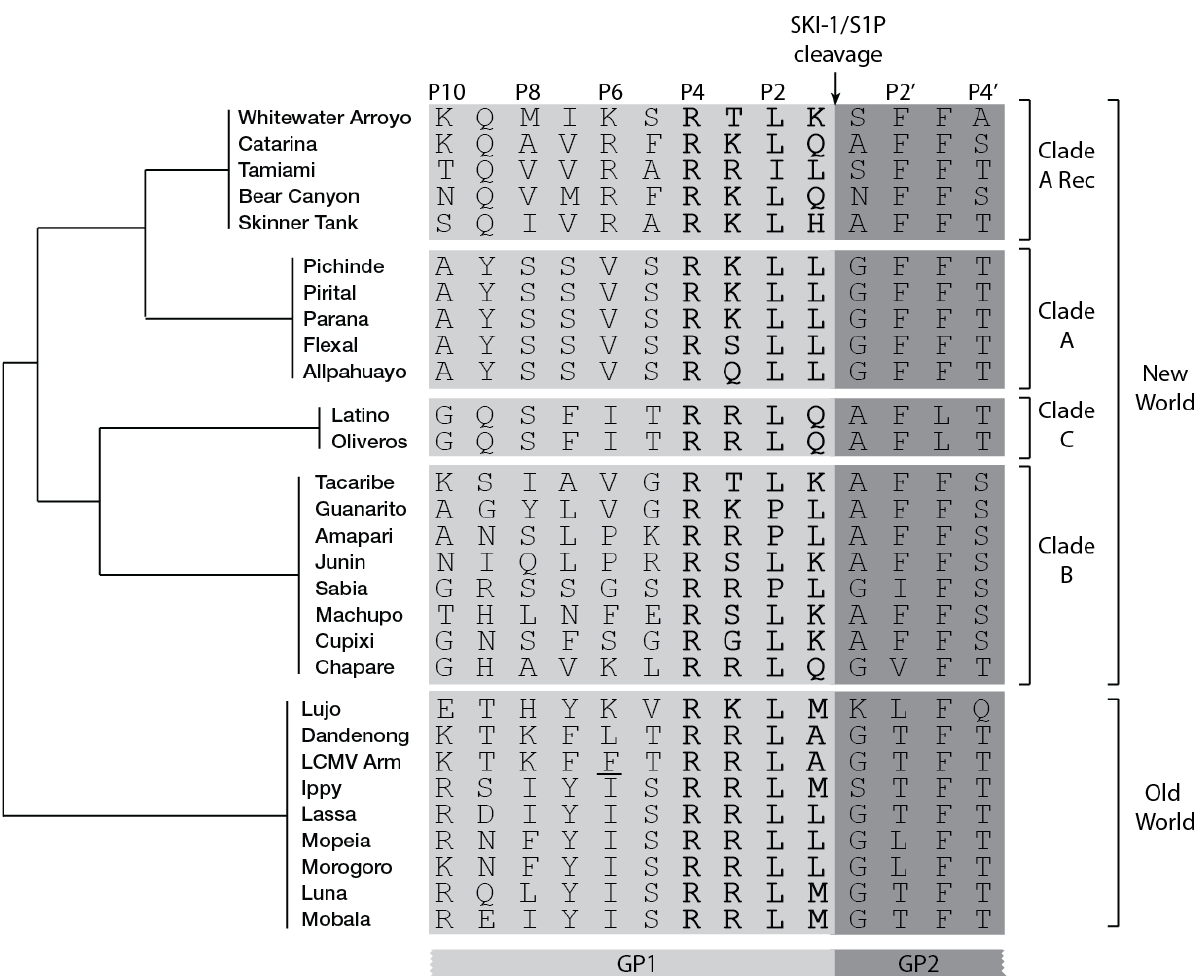
Figure 2. Amino acid sequence aligment of arenaviruses GPC residues surrounding the cleavage site (indicated by arrow). Residues of mature GP1 are in light gray while residues of mature GP2 are in darkgray. The four amino acids of clevage site motif are in bold. The schematic cladogram indicates the phylogenetic relationships between the viral clades is shown on the right. The LCMV cl13 strain amino acid variant F260L is underlined. Accession numbers are in supplementary table